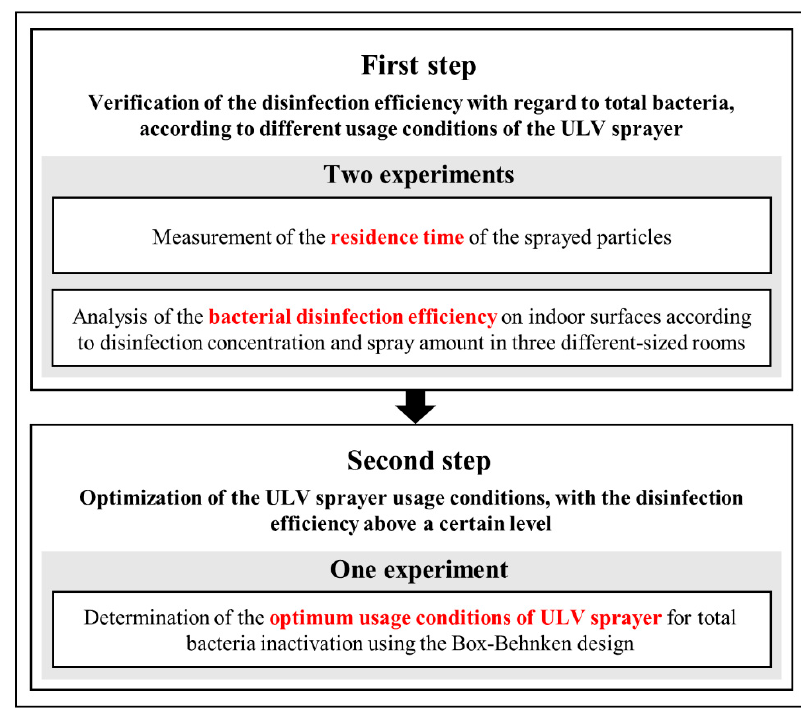
Figure 2. Flow-chart of the experiments.